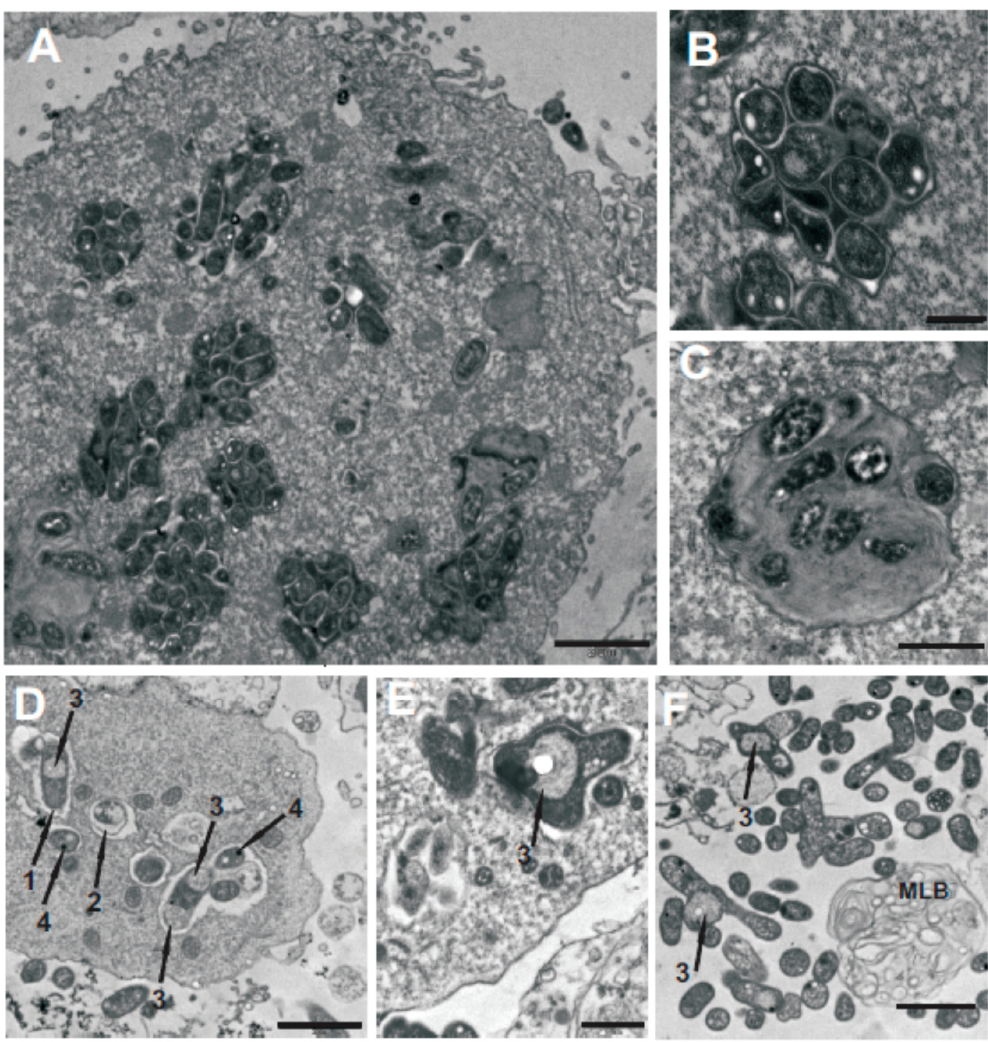
Figure 6. 24-h co-culture assays. Transmission electron microscopy (TEM) images of A. castellanii filled with M. loti cells: ( A – C ) WT, ( D – F ) NZP2213.1 mutant. Scale bars: 2 µm ( A , D , F ), 1 µm ( E ), and 500 nm ( B , C ). Arrows: 1—membrane ruffling, 2—membrane detachment, 3—cytoplasm release, 4—electron-dense dots. Abbreviation: MLB—multilamellar body.